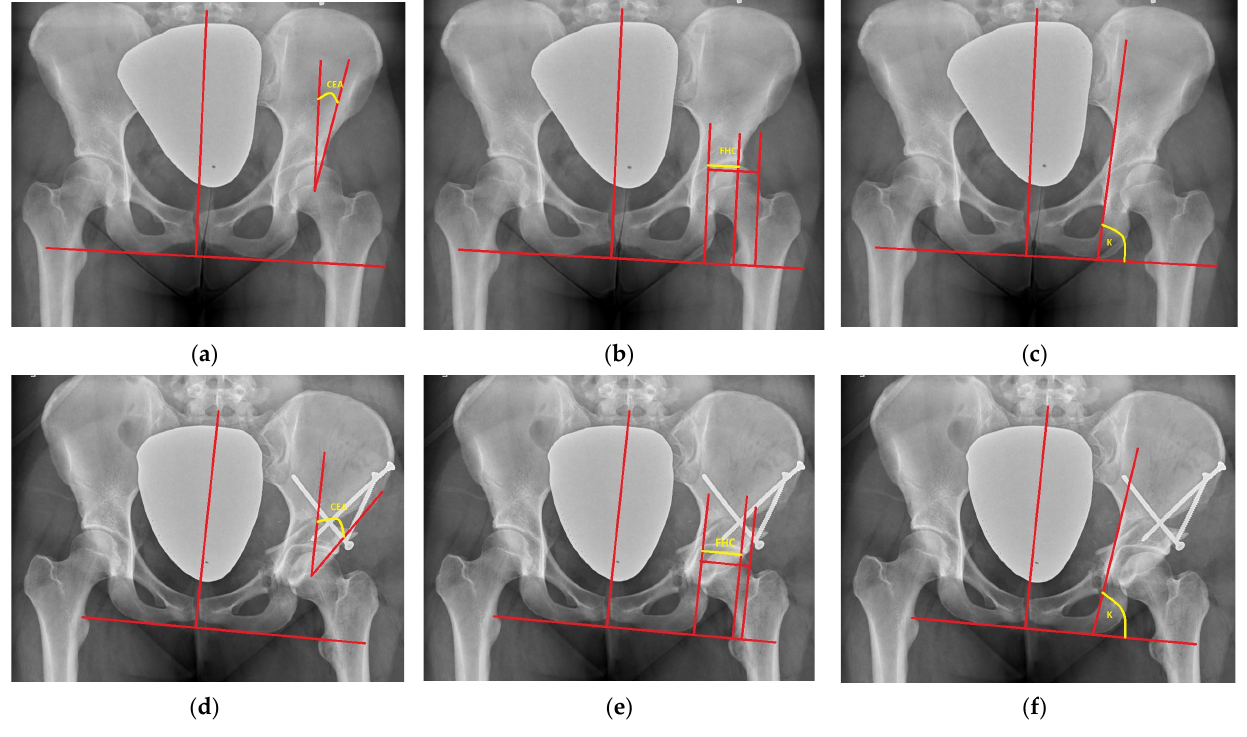
Figure 3. ( a – c ) Radiographic measurements of CEA (10°), FHC (52%), and K ilioischial angle (87°) preoperatively; ( d – f ) radiographic measurements of CEA (28°), FHC (80%), and K ilioischial angle (82°) postoperatively.